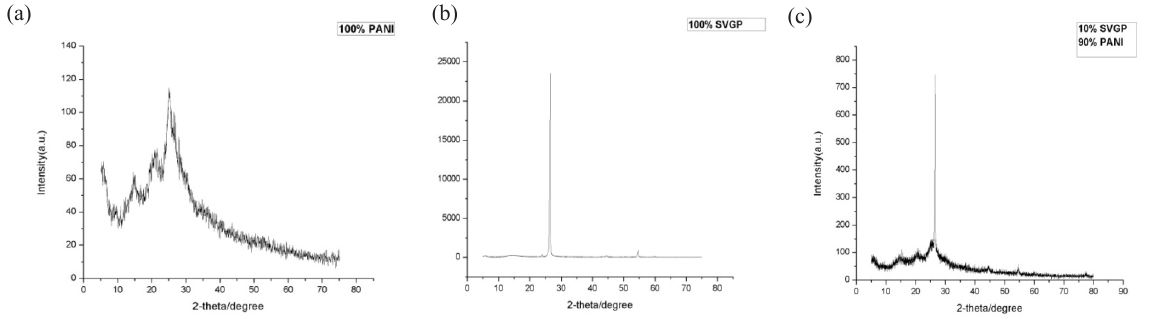
Figure 2: PXRD patterns of (a) 100% PANI (b) 100% SLVG (c) 10%/90% SLVG/PANI